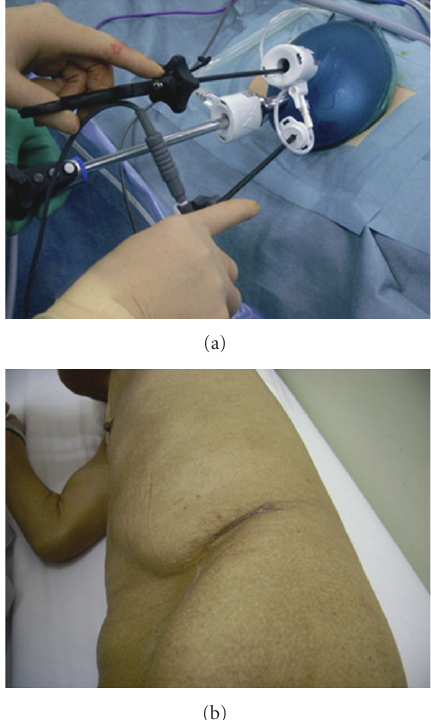
Figure 2: (a) Actual port placement for a left nephrectomy. (b) Photograph of a patient’s abdomen 1 month postoperatively.